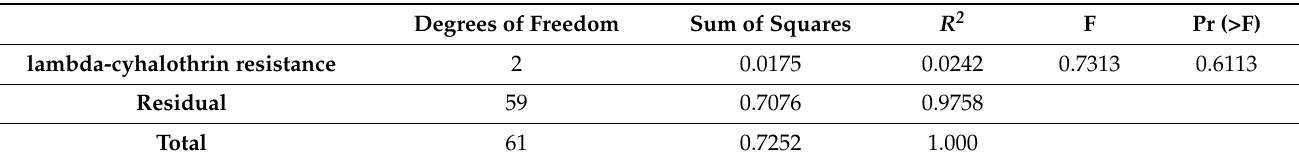
Table 2. Beta diversity analysis of Ae. aegypti midgut bacteria for lambda–cyhalothrin resistance status using the Adonis2 test.